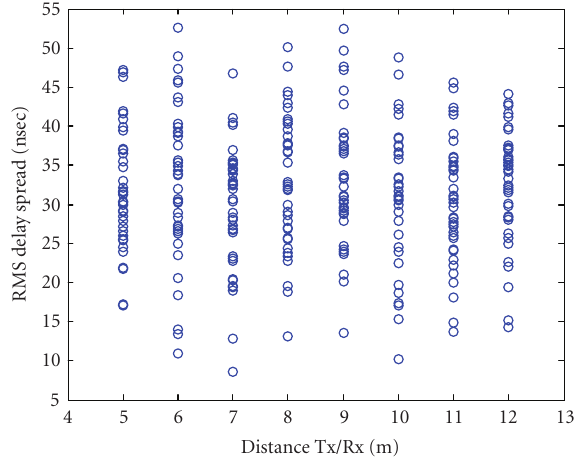
Figure 13: RMS delay spread versus mean excess delay, all channels, NLOS (15dB